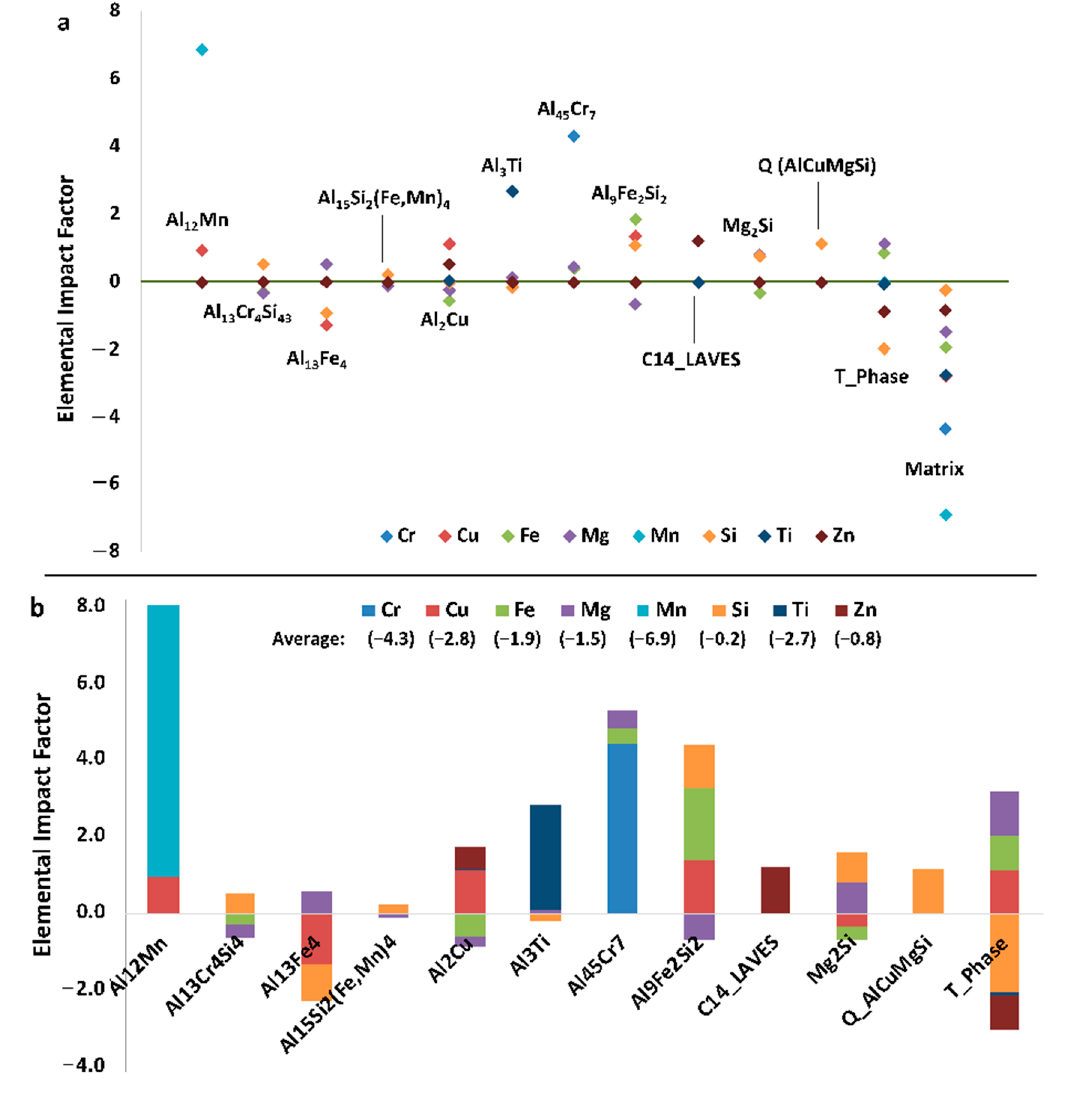
Figure 20. ψ values for Al 6061 at 25 ◦ C. ( a ) The compilation of the ψ s for the matrix and most abundant secondary phases present in Al 6061 at 25 ◦ C. ( b ) The cumulative ψ s for each equilibrium phase and element in Al 6061. For ( a , b ), chromium is identified with the blue color, copper is associated with the red color, iron is identified with the green color, magnesium is associated with the purple color, manganese is identified with the light blue color, silicon is associated with the orange color, titanium is identified with the dark blue color, and zinc is associated with the brown color in the plots.